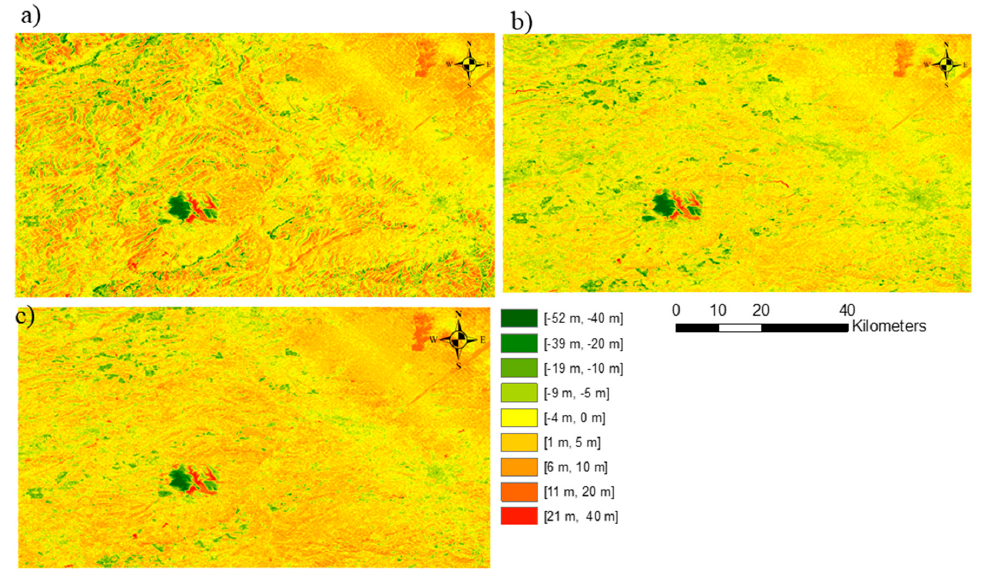
Figure 16. Difference of elevations between the reference DEM and ( a ) the original SRTM 30 DEM, ( b ) the rebuilt DEM using rivers and streams, and ( c ) the rebuilt DEM using the rivers.